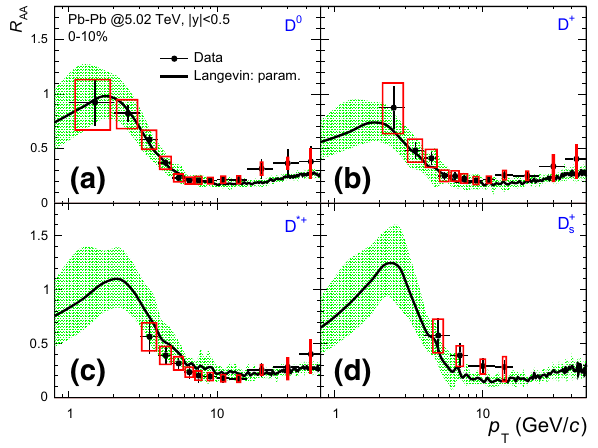
Fig. 4 Comparisonbetweenexperimentaldata(redbox[41])andLGR Model-B calculations (solid black curve with green uncertainty band) for the nuclear modification factor R AA , of a D 0 , b D + , c D ∗+ and d D + s at mid-rapidity ( | y | < 0 . 5) in the (0–10%) centrality Pb–Pb √ s NN = 5 . 02 TeV collisions at